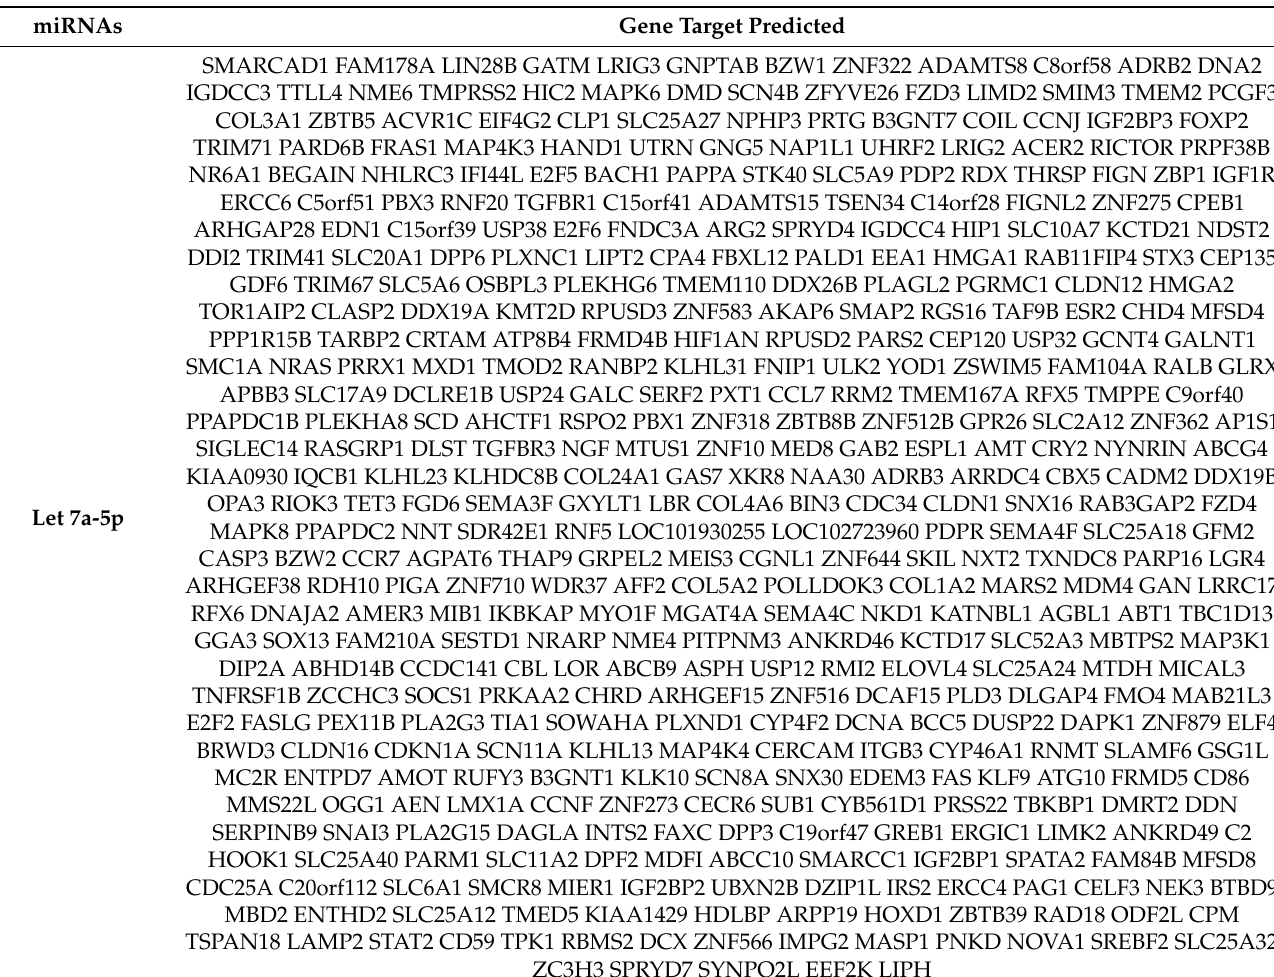
Table 4. miRNAs predictive target